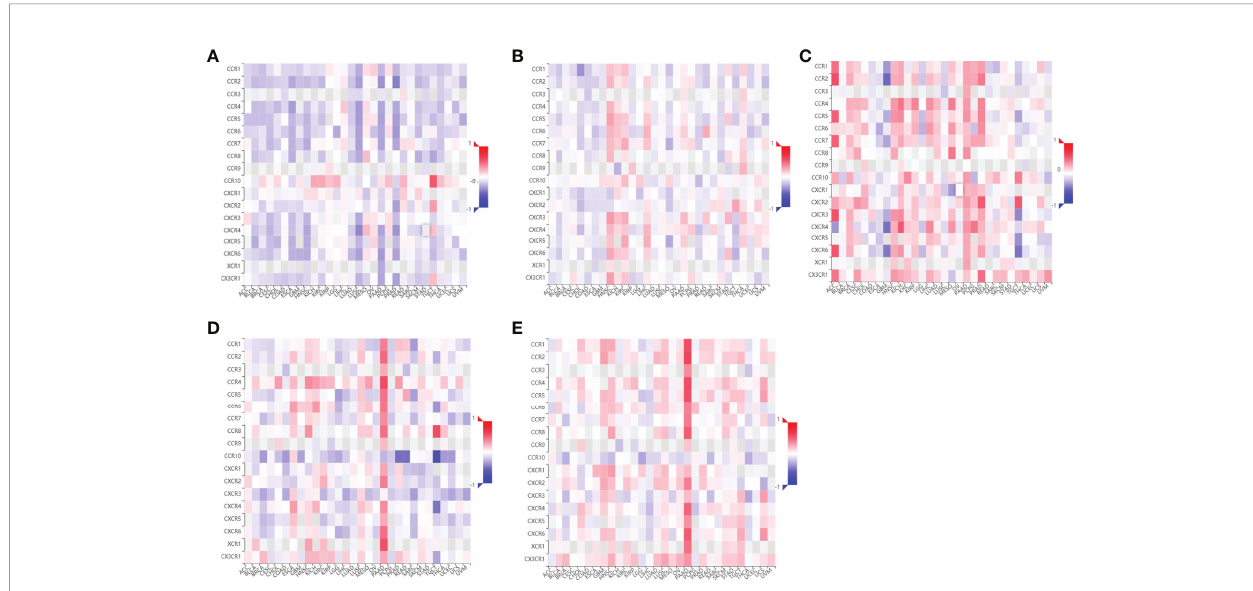
FIGURE 9 | Correlations between chemokine receptors and the 5 core target genes were analyzed using TISIDB database. (A) AKT1-chemokines receptors. (B) TP53-chemokines receptors. (C) NOTCH1-chemokines receptors. (D) SIRT1- chemokines receptors. (E) PTEN-chemokines